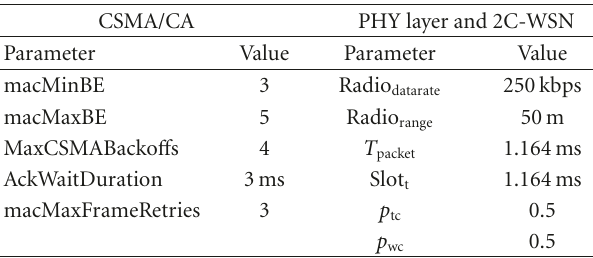
Table 1: Relevant simulation